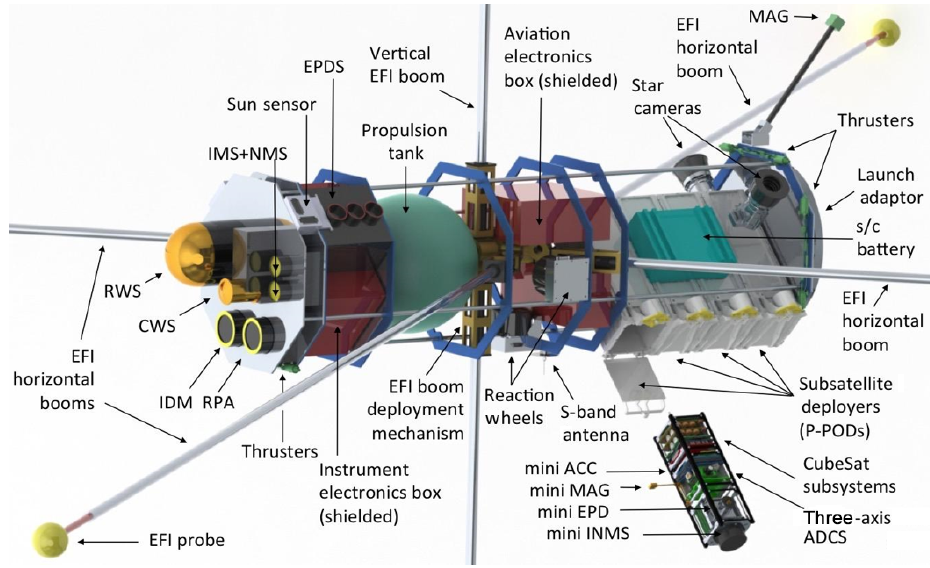
Figure 19. Interior of the main Daedalus satellite, including key s / c subsystems and instrumentation. A deployed CubeSat subsatellite is also shown, with examples of potential subsatellite miniaturized